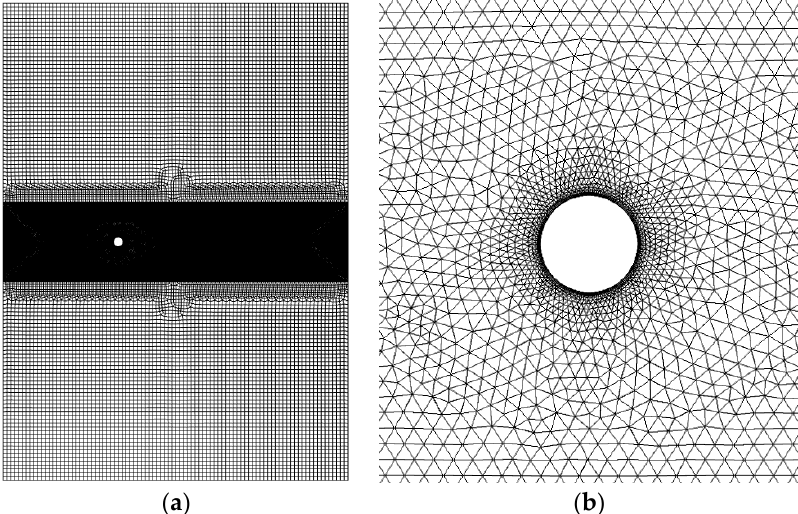
Figure 8. Grids system for the validation problem: ( a ) distribution of 31,904 elements, ( b ) zoomed view around a body. Table 3. Numerical values of drag coefficients with power-law analysis around a circular obstacle.